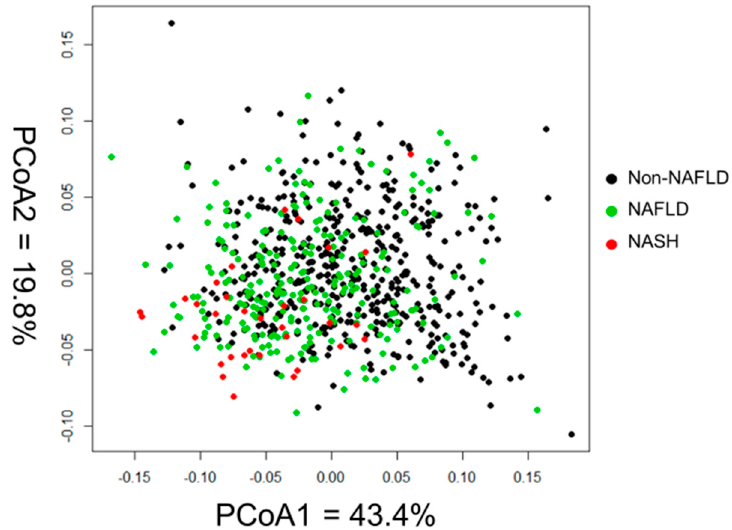
Figure 2. Principal coordinate analysis of the amino acid composition among normal subjects, subjects with nonalcoholic fatty liver diseases, and subjects with liver fibrosis.